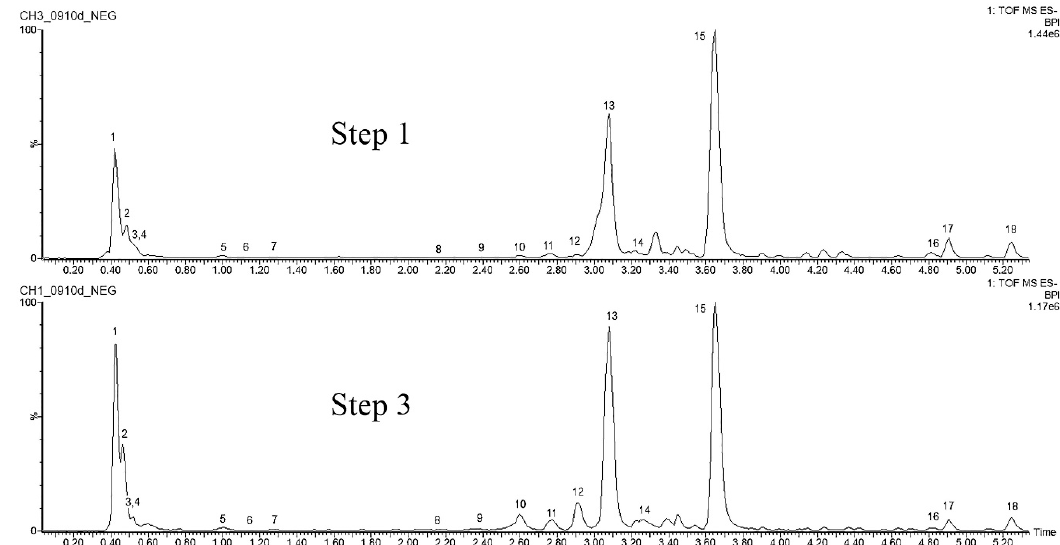
Figure 7. Base peak ion chromatograms comparing steps 1 to 4 of the leaf explants from Clidemia hirta.